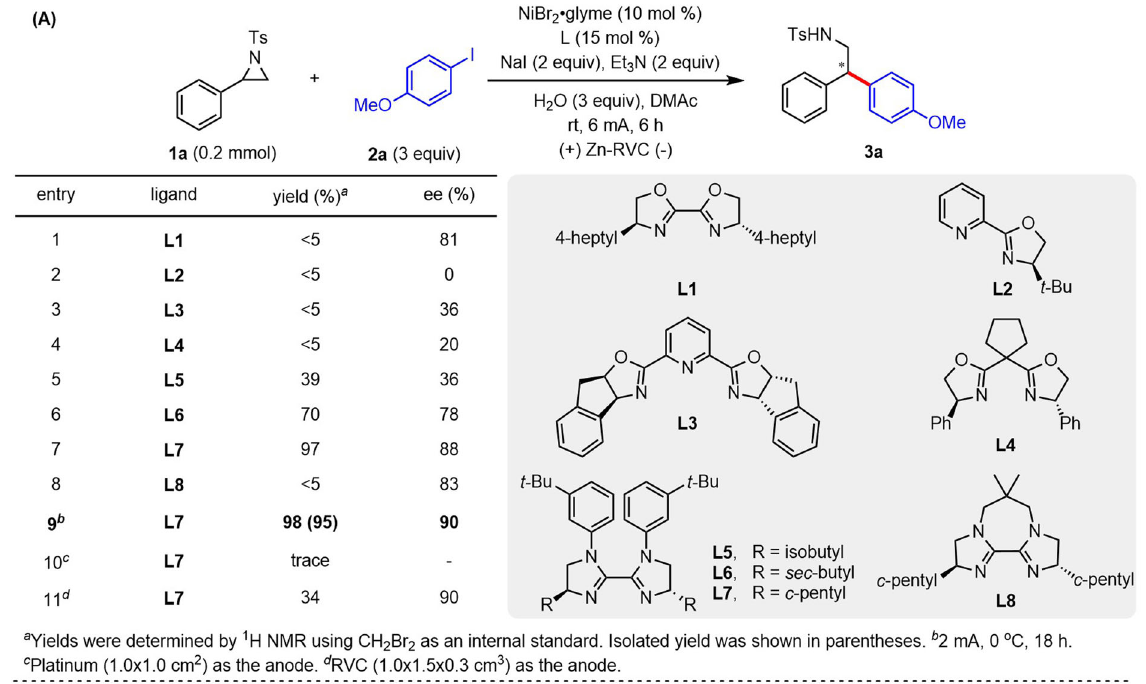
Fig.2|Reactionoptimization.A Ligandevaluation. B , C Voltaicpro fi lesoftheZn/ Pt anode (red) and RVC cathode (black). D Cyclic voltammograms were recorded on a glassy carbon WE and Pt CE.DMAc containing 0.1M n -Bu 4 NPF 6 and 5mM [Ni] and5mM L n .PotentialswerecalibratedwithFcasaninternalstandard. E NPA1,the